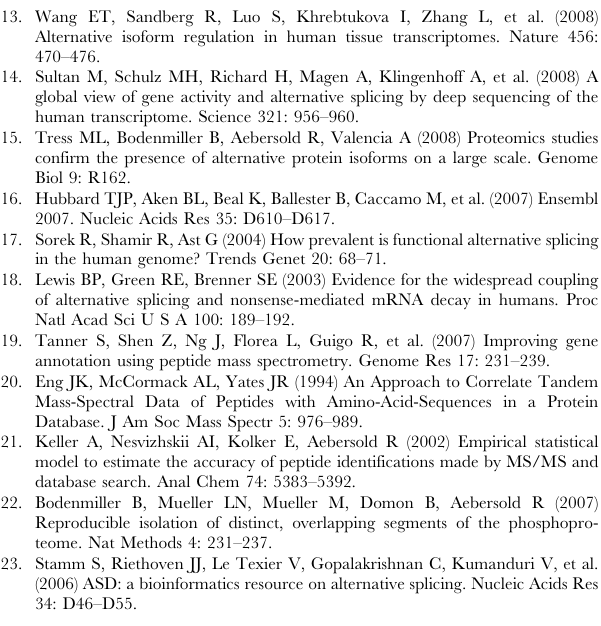
Table S3 KEGG annotations for all of the 89 genes found to be alternatively spliced and represented in the IPI data. In total, 32 pathways were found. These pathways are sorted by impact factor, a probabilistic term which is calculated from the number of genes in the input file, the size of the reference chip (U133 plus2.0), the number of input genes that are on a given pathway and the number of the pathway genes represented on the reference chip.